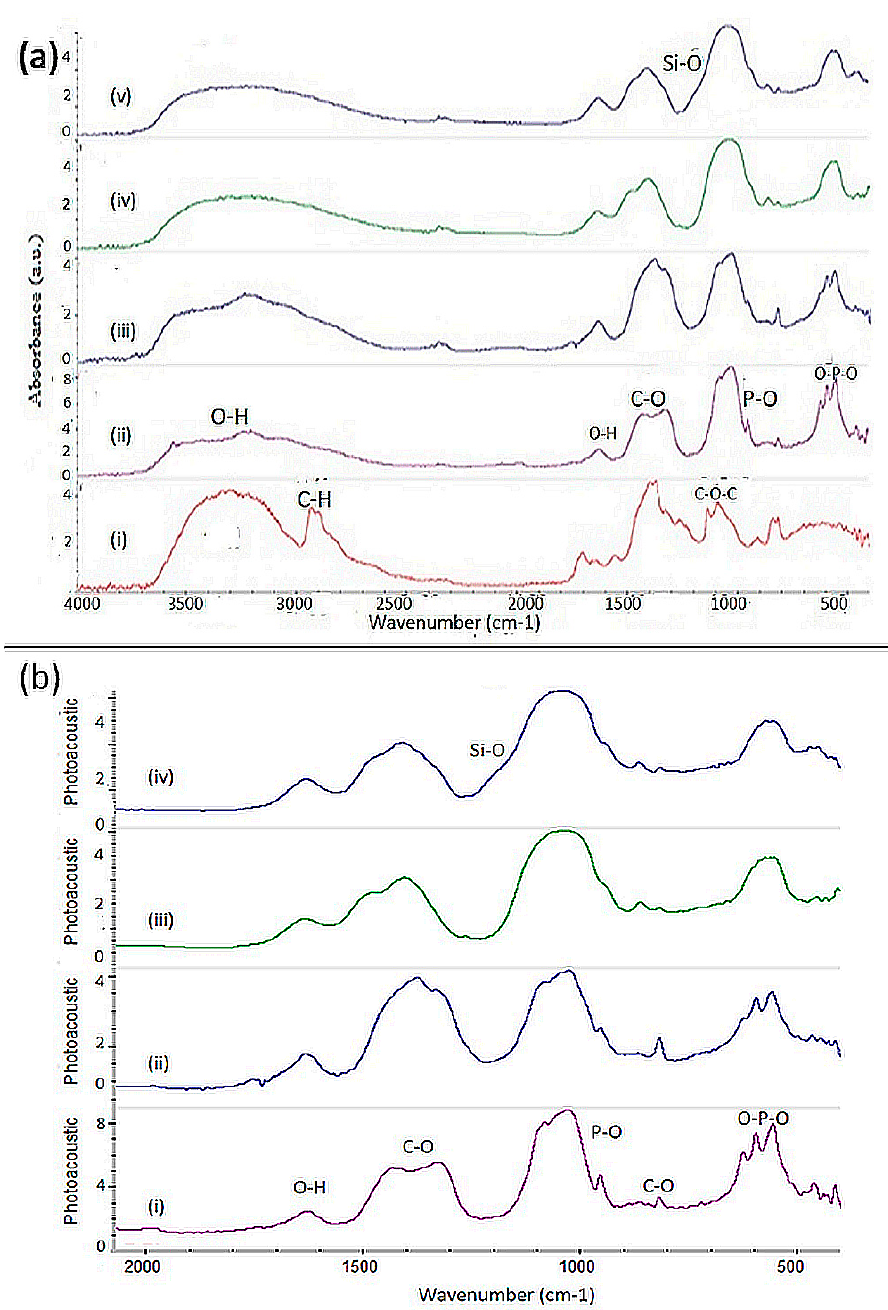
Figure 1. ( a ) Comparative IR spectra showing the characteristic peaks of (i) polyvinyl alcohol